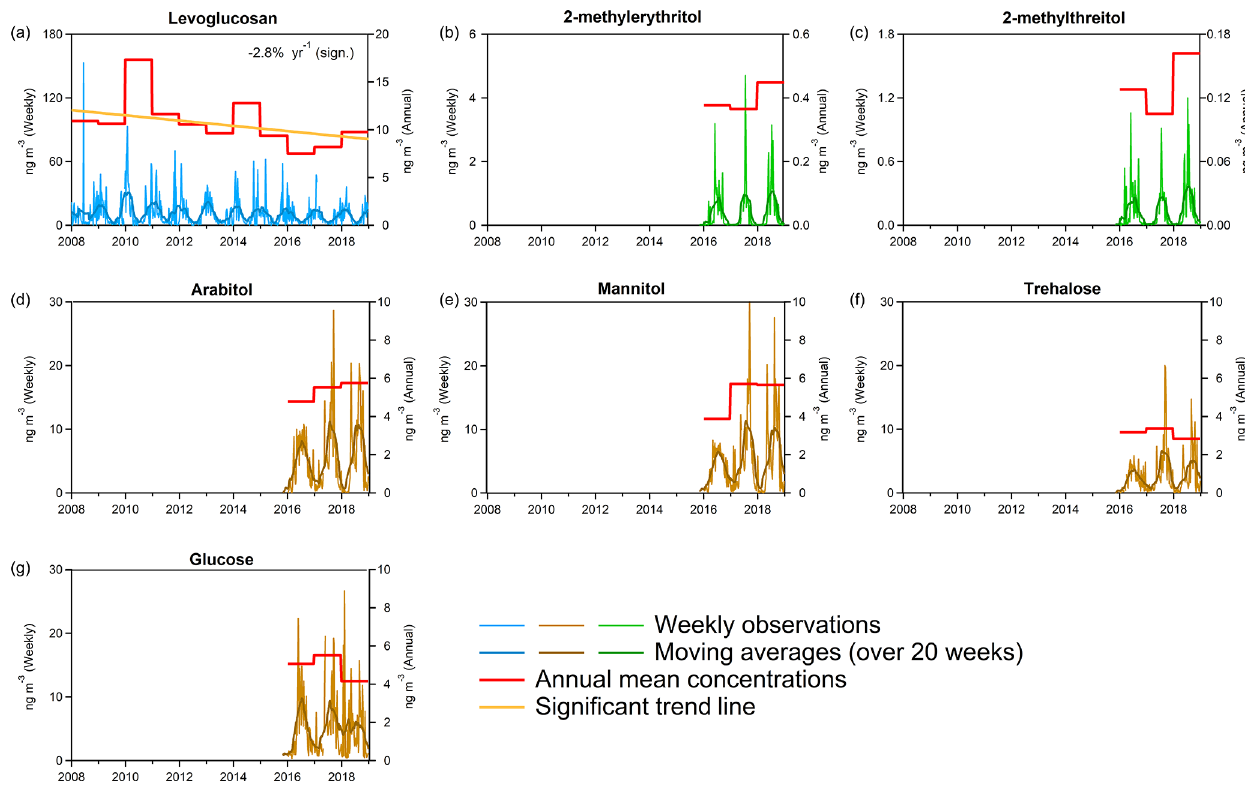
Figure 6. Ambient aerosol concentrations of organic tracers in PM 10 , showing levoglucosan, 2-methylerythritol, and 2-methylthreitol (up- per panels); arabitol, mannitol, and trehalose (middle panels); and glucose (bottom panel), presented as weekly (168h) and annual mean concentrations for the Birkenes Observatory for the 2008–2018